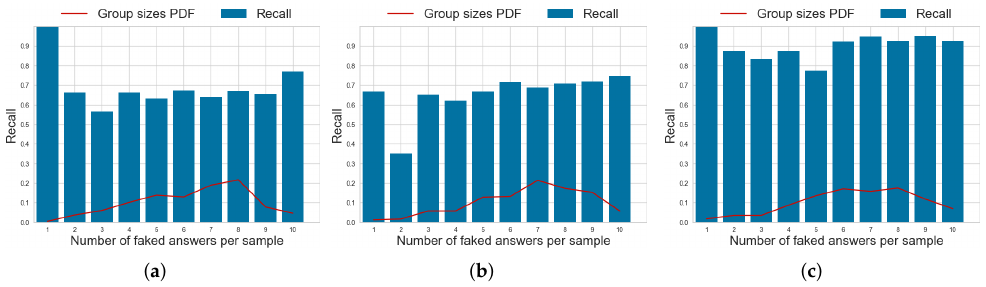
Figure 8. Probability density function (PDF) of the number of faked responses per questionnaire and per-item recall for the faking detection task using the SABA model on different datasets. ( a ) dataset CC . ( b ) dataset JIS . ( c ) dataset JIHO